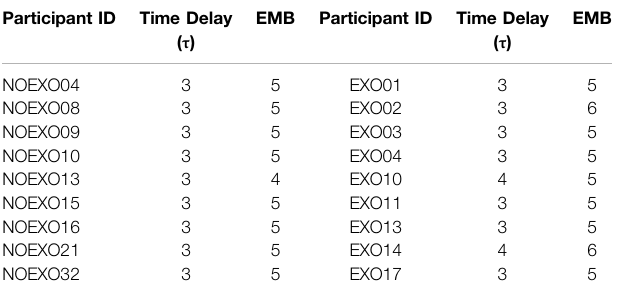
TABLE 2 | Participant demographics. The two groups were not different in any of the demographics or measured walking speeds. PWS = preferred walking